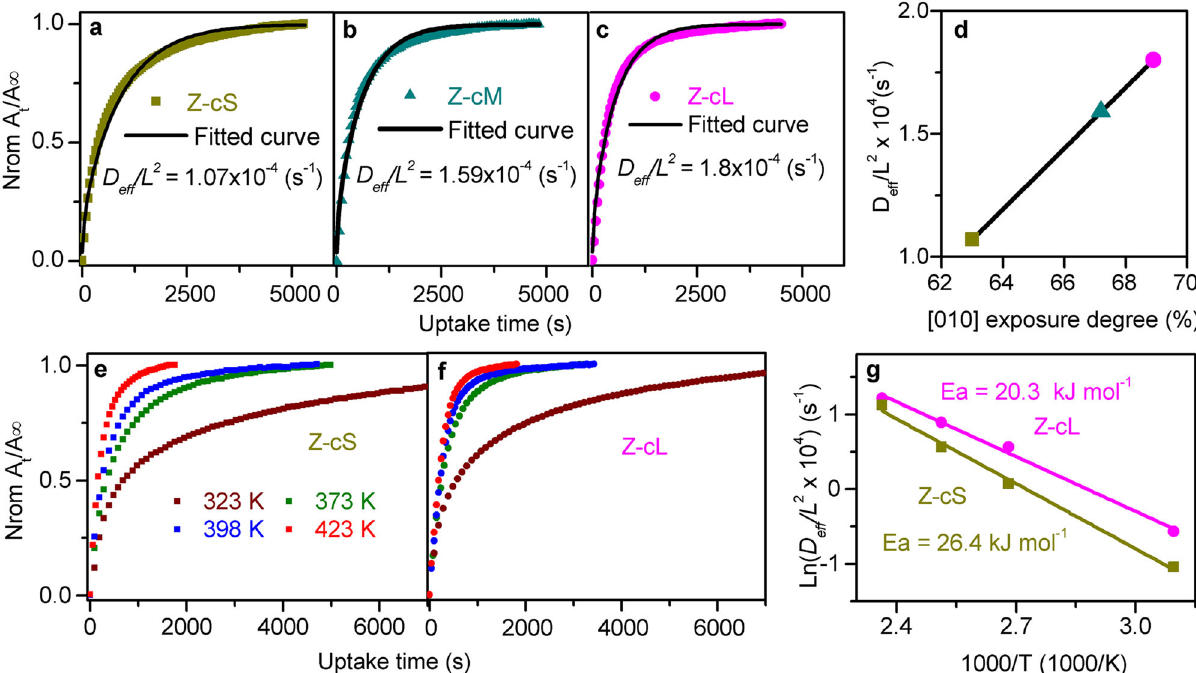
Fig. 4 Diffusion behaviors of C 4 = in H-ZSM-5 zeolites. Uptake curves of C 4 = over H-ZSM-5 samples with different length of c -axis: a Z-cS, b Z-cM, c Z-cL. d Correlation of the [010] exposure degrees of H-ZSM-5 zeolites with the diffusion rates fi tted by Eq. 6. e , f Uptake curves of C 4 = over Z-cS and Z-cL with different temperature. g Arrhenius plot of diffusion rates over Z-cS and Z-cL. The detailed conditions of diffusive measurements are displayed in the “ Methods ” section. The error bars are smaller than the data points in Fig. 4d,